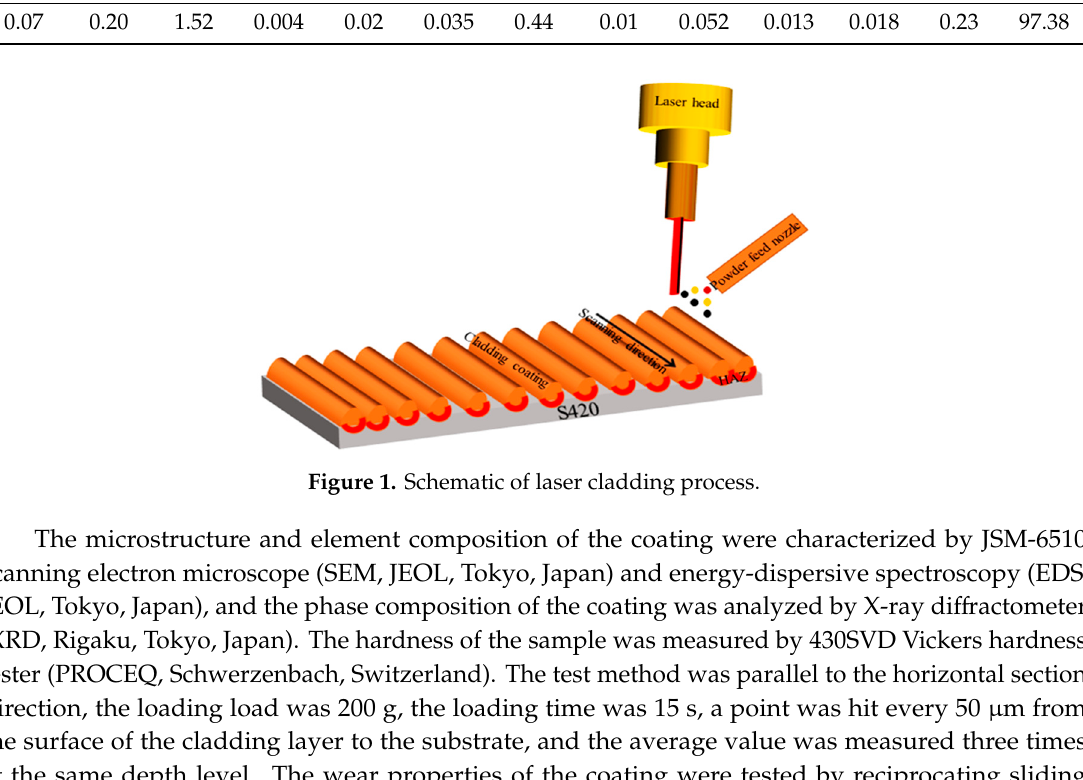
Figure 2. Schematic diagram of impact specimens.